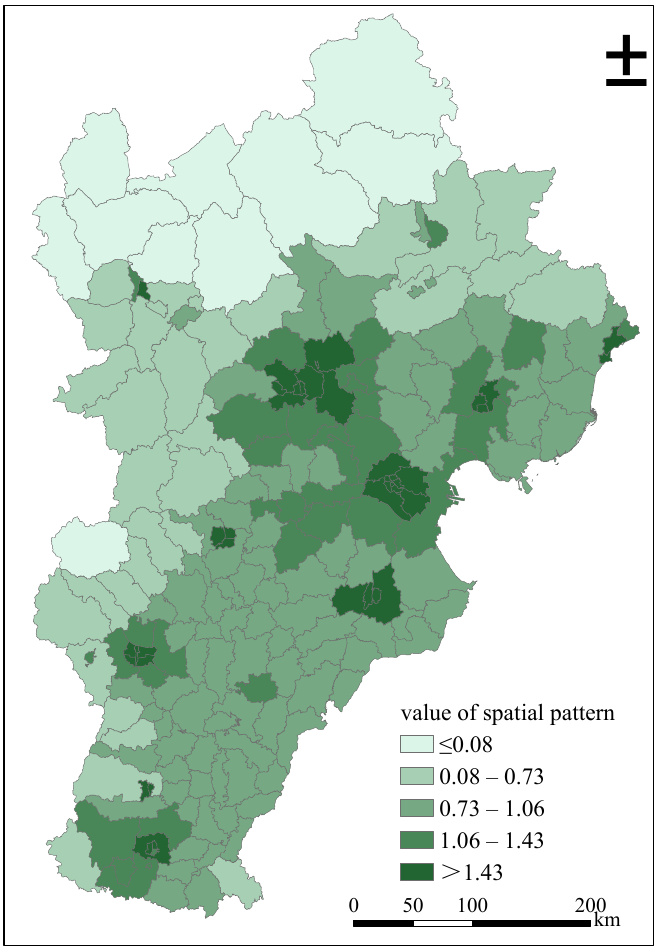
Figure 4. Estimated spatial patterns of urban expansion. Value of spatial pattern presents the estimates of spatial distributions of urban expansion, net of covariate effects.